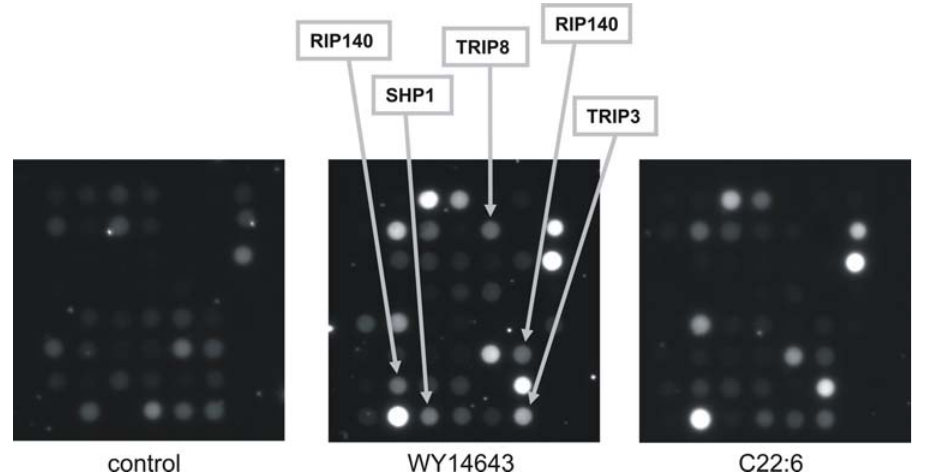
Figure 6. Cofactor recruitment assay with WY14643 and C22:6. The Nuclear Receptor PamChip H assay was used to measure the interaction between PPAR a and immobilized peptides corresponding to specific coregulator-nuclear receptor binding regions. Measurements were performed in the presence of control (EtOH), WY14643 (5 m M) or C22:6 (100 m M). Arrows point to those co-activators selectively recruited by WY14643 but not C22:6. All images were taken after 100 msec exposure time.